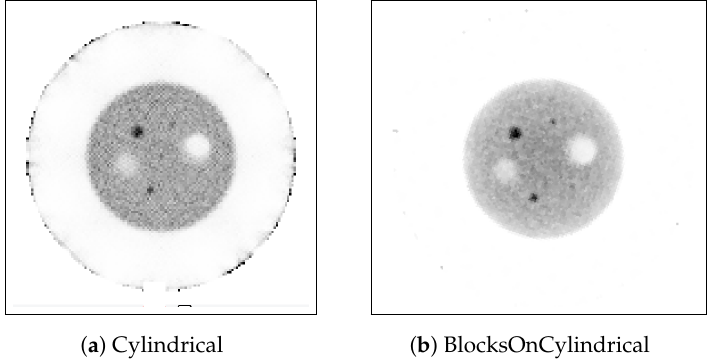
Figure 11. Transverse view of reconstructed image quality phantom produced by the: ( a ) “Cylindrical” class with all corrections, ( b ) “BlocksOnCylindrical” class with all corrections. Table 3. Image quality phantom: cold a and hot b rod contrast [12]. Rod Cylindrical BlocksOnCylindrical Diameter, Contrast, Background Contrast, Background mm % Variability, % % Variability, % 20 a 78 4.9 75 4.8 15